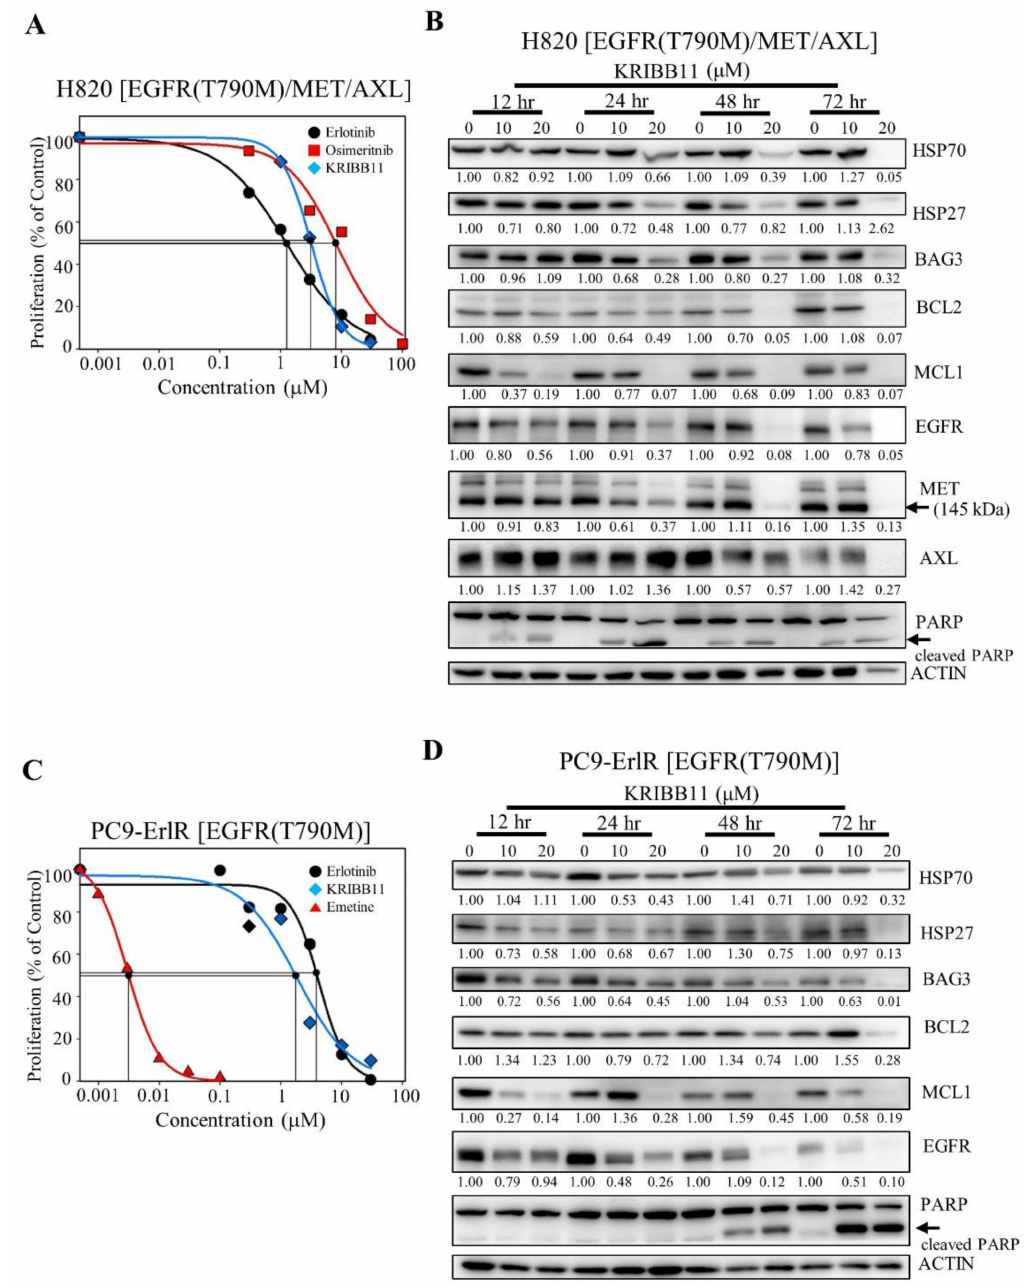
Figure 5. KRIBB11 decreases the amount of HSF1 downstream proteins, such as HSP70, and HSP70/HSP90 client proteins such as EGFR. ( A ) NCI-H820 cells were treated with 0.1% DMSO or different concentrations of erlotinib, osimertinib, and KRIBB11. After incubation for 72 h, cells were counted using a microscope. Proliferation is expressed as the percentage of erlotinib-, osimertinib-, and KRIBB11-treated cells compared with 0.1% DMSO-treated cells. Each value is the mean ± S.D. ( B ) NCI-H820 cells were treated with 0.1% DMSO or KRIBB11 (10, 20 µ M) for 12–72 h, and whole cell lysates were analyzed by Western blotting using the indicated antibodies (the protein band intensity was normalized to the actin band intensity). ( C ) PC9-ErlR cells were treated with 0.1% DMSO or different concentrations of erlotinib, KRIBB11, and emetine. After incubation for 72 h, cells were counted using a microscope. Proliferation is expressed as the percentage of erlotinib-, KRIBB11-, and emetine-treated cells compared with 0.1% DMSO-treated cells. Each value is the mean ± S.D. ( D ) PC9-ErlR cells were treated with 0.1% DMSO or KRIBB11 (10, 20 µ M) for 12–72 h, and whole cell lysates were analyzed by Western blotting using the indicated antibodies (the protein band intensity was normalized to the actin band